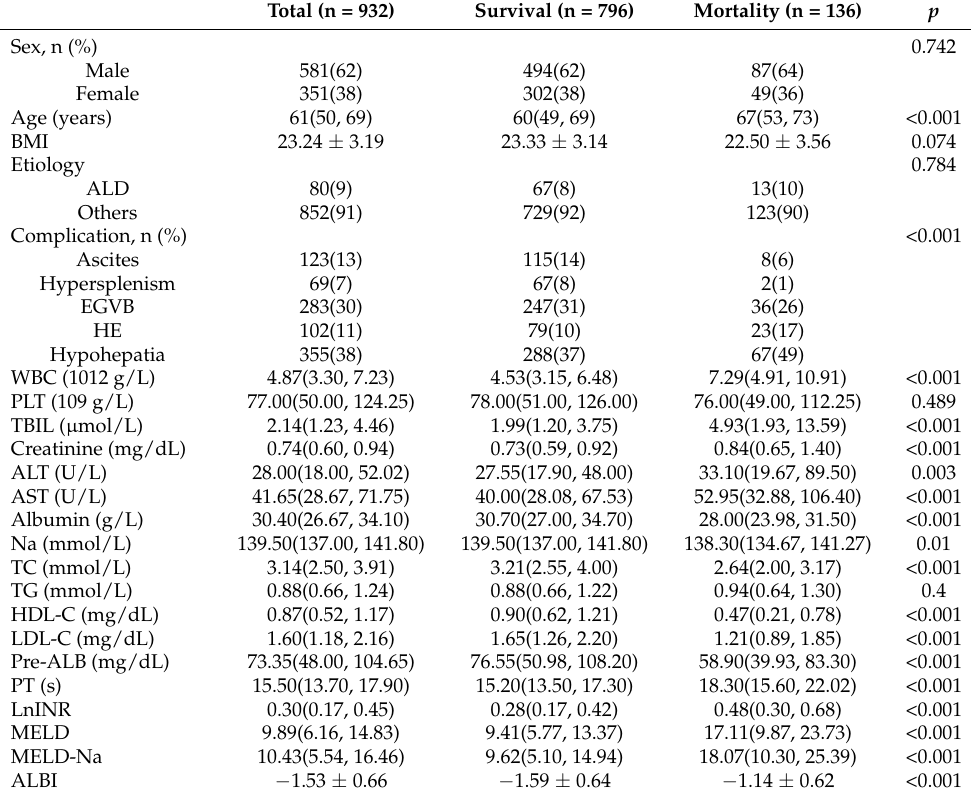
Table 1. Characteristics of patients with non-cholestatic cirrhosis by 30-day mortality. Total (n = 932) Survival (n =